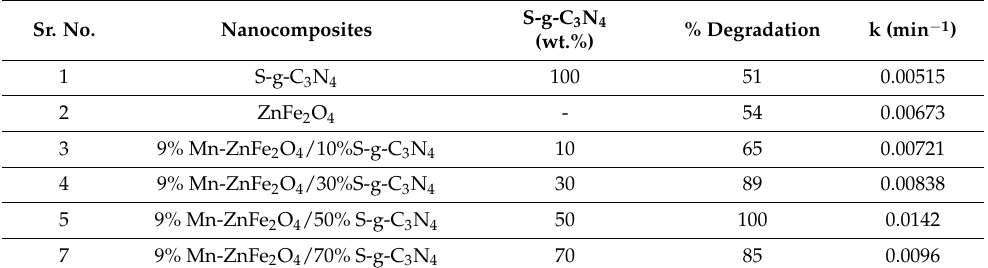
Table 2. The rate constant (k) values of the 9% Mn-ZnFe 2 O 4 /50% S-g-C 3 N 4 nanocomposites. Sr. No.